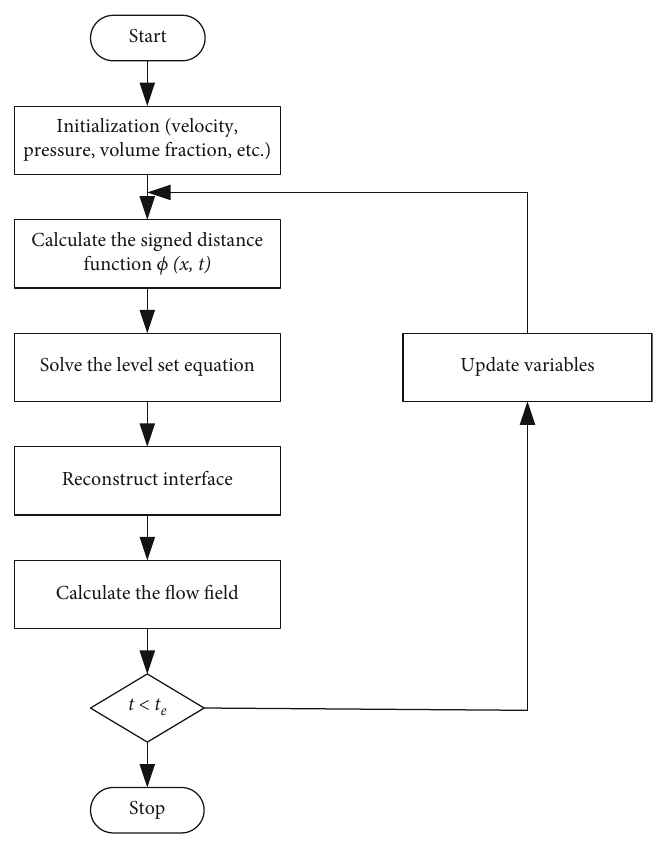
Figure 5: Flow chart showing the coupled computing scheme.